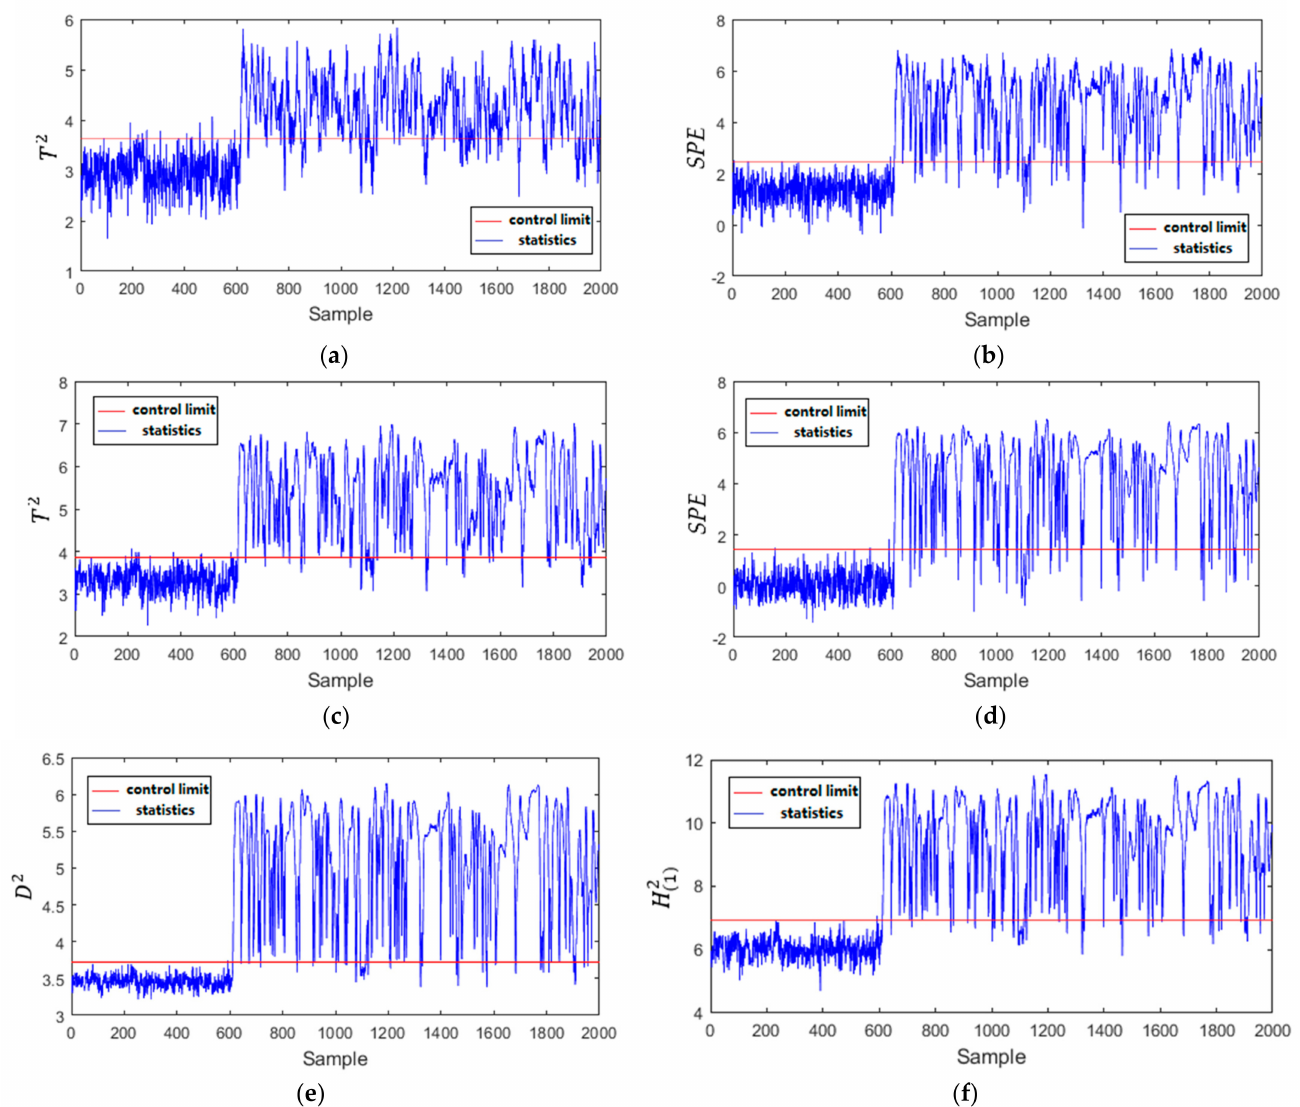
Figure 10. Monitoring results of Fault 25 in Mode 1: ( a ) LNS-PCA ( T 2 ); ( b ) LNS-PCA ( SPE ); ( c ) GMM-SDAE ( T 2 ); ( d ) GMM-SDAE ( SPE ); ( e ) MD-kNN; ( f )